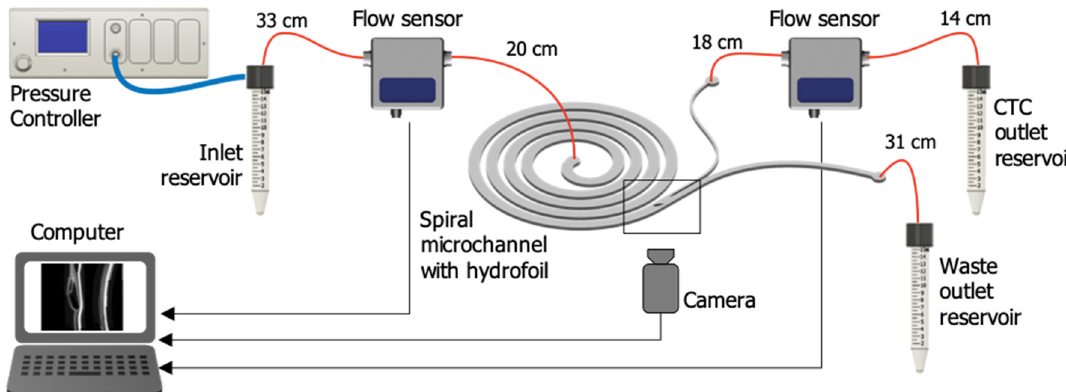
Figure 4. Test setup. A pressure-driven flow was generated inside the microfluidic chip using a pressure controller connected to pressurized N 2 . Two flow sensors were used for continuous measurement of the flow rate at the inlet and waste outlet of the chip. A custom-designed microfluidic chip holder houses the microfluidic chip and facilitates fluidic connections to the microchannel. An inverted fluorescent microscopy equipped with a highspeed camera connected to a computer were used for optical observation. Fused silica tubing was used to make fluidic connections (red lines).